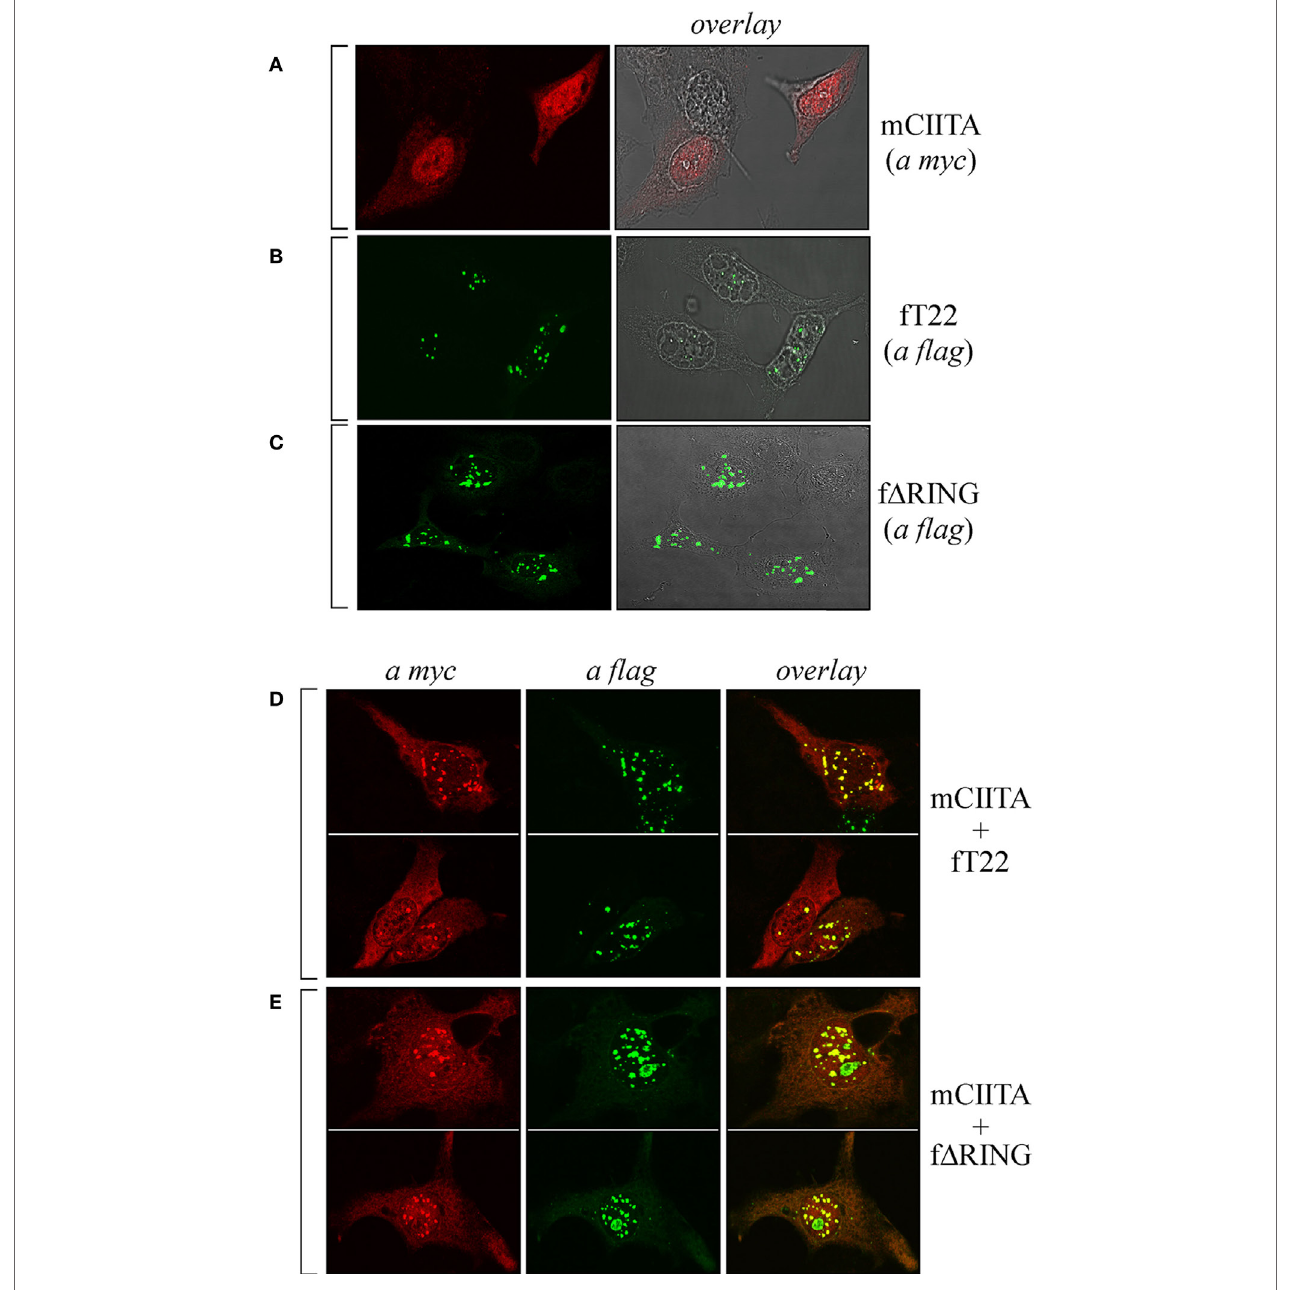
FigUre 2 | The subcellular distribution of class ii transactivator (ciiTa) is affected by tripartite motif-containing protein 22 (TriM22) . Hep-2 cells were transfected with either myc-tagged CIITA (mCIITA) (a) , flag epitope-tagged TRIM22 full-length (fT22) (B) , or flag epitope-tagged TRIM22- Δ RING (f Δ RING) (c) vectors alone. (a–c) The overlay panels were obtained by merging the differential interference contrast image with the corresponding immunofluorescence image. mCIITA was co-transfected in Hep-2 cells either with fT22 (D) or f Δ RING (e) , as specified on the right of the panels. Cells were fixed, first stained with anti-myc rabbit polyclonal antibody followed by goat anti-rabbit AlexaFluor 546-conjugated antibody to detect myc CIITA and then stained with fluorescein isothiocyanate- conjugated anti-flag antibody to detect flag-TRIM22 (fT22) or flag- Δ RING deletion mutant. Each panel shows at least two representative fields. (a–e) Stained cells were then analyzed by confocal microscopy, as described in Section “Materials and Methods.”